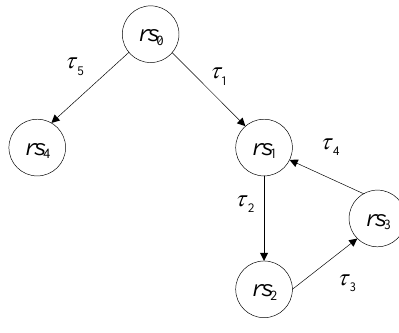
Figure 10. Reduced